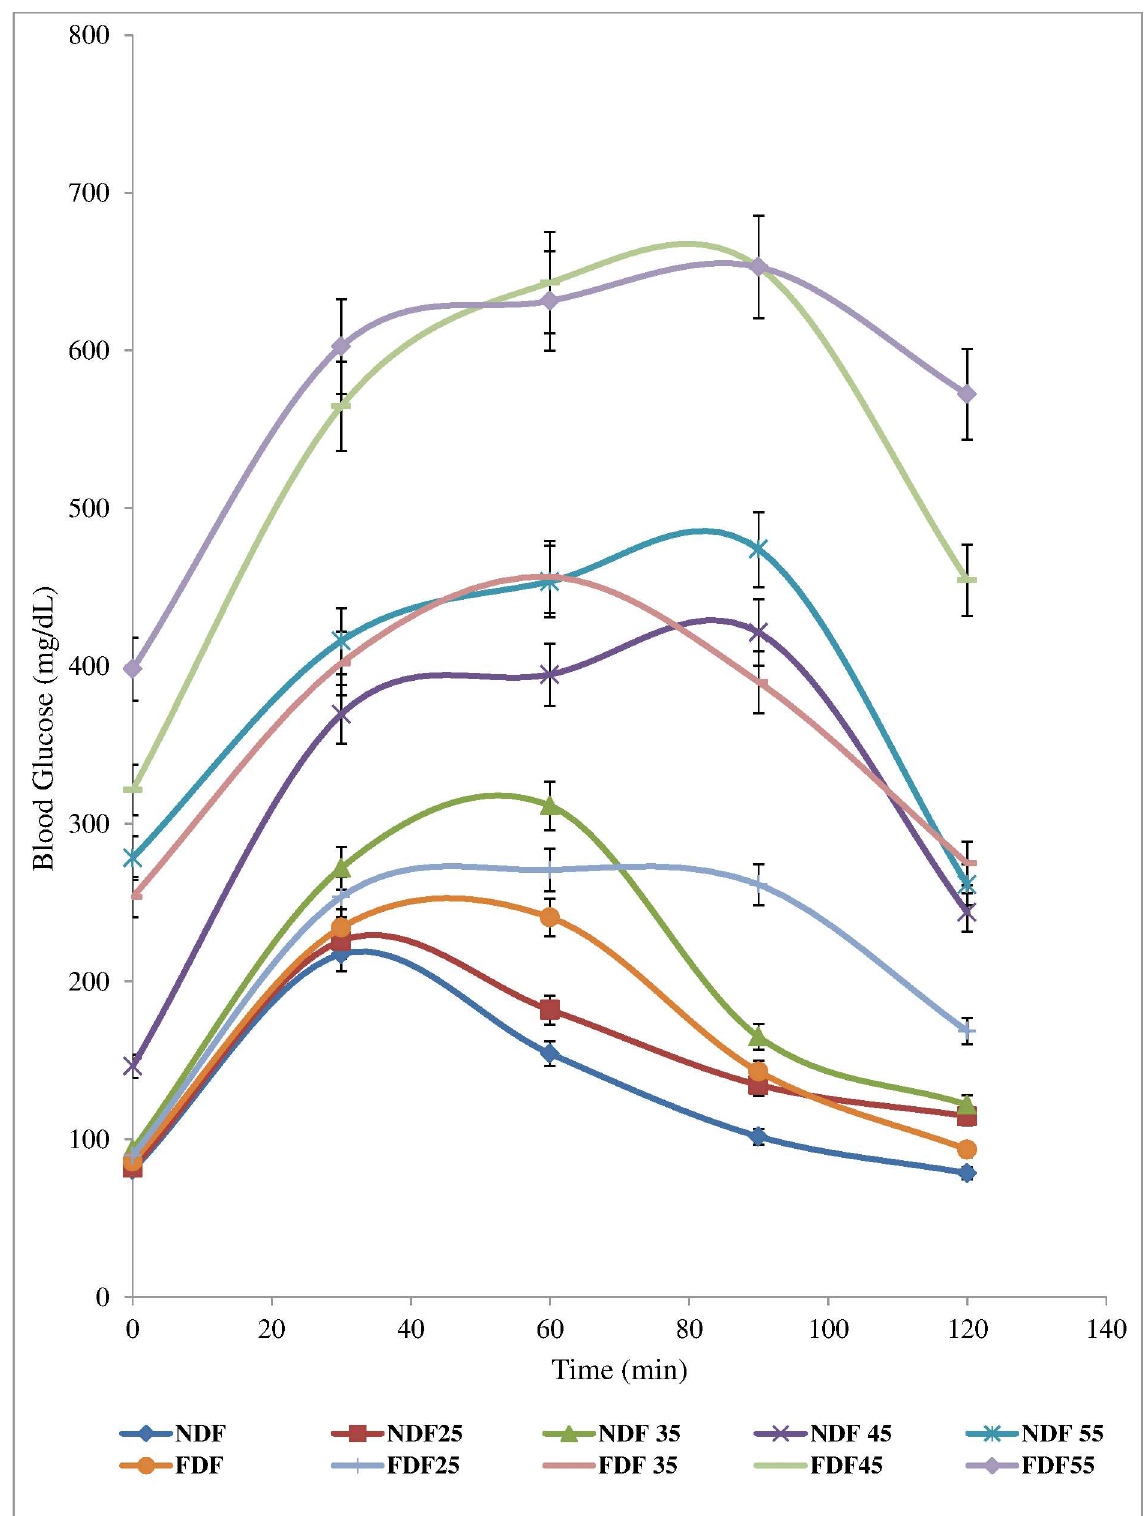
Fig 2. Oral Glucose Tolerance Test. Data are presented as mean ± SD of 6–8 animalsper group. NDF: Group fed with Normal Diet Feed + water and treated with normal salineas control NDF 25 : Group fed with Normal Diet Feed + Water and treated